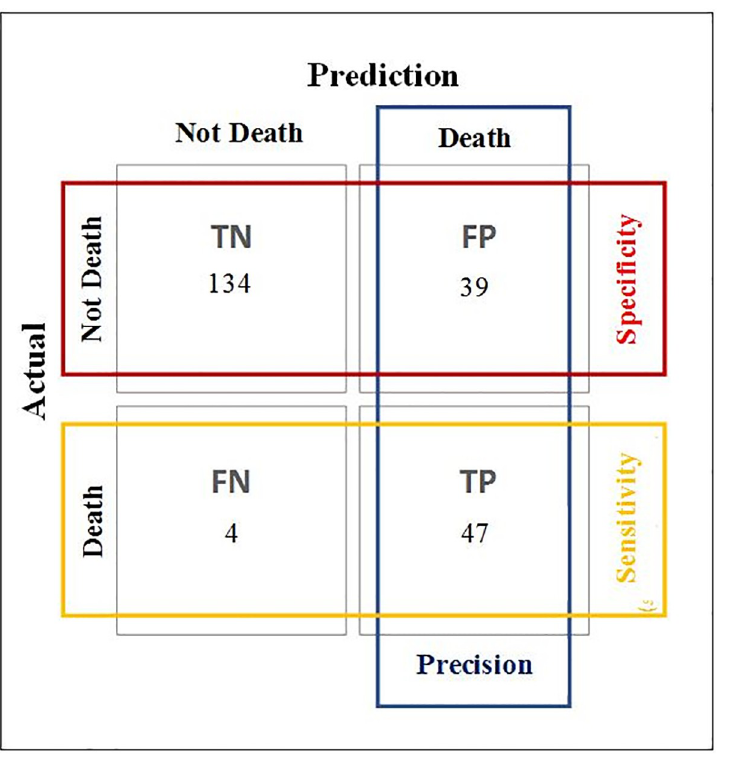
Fig 3. Confusion matrix of the RF algorithm.